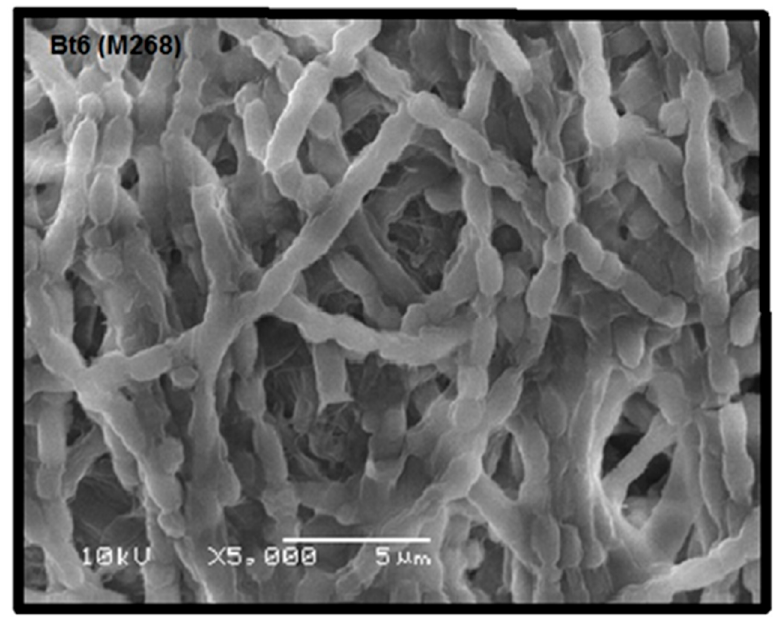
Figure 2. Scanning electron micrograph of Bt6 isolate at magnification of 5000 × showing characteristic hexagonal attached crystals (arrow head).